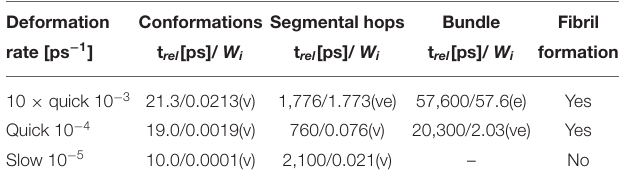
TABLE 2 | Relaxation times (t r el ) and Weissenberg numbers ( W i ) for various relaxation processes at different stretching rates; viscous (v); elastic (e); viscoelastic process (ve).